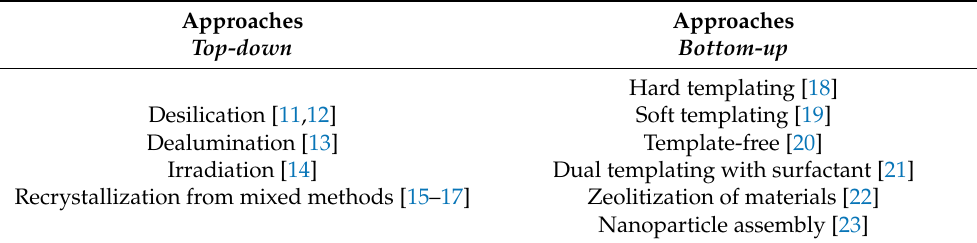
Table 1. Main methods for the synthesis of hierarchical